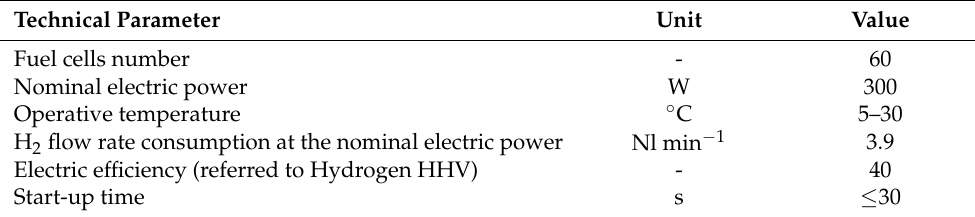
Table 1. Main PEM stack technical